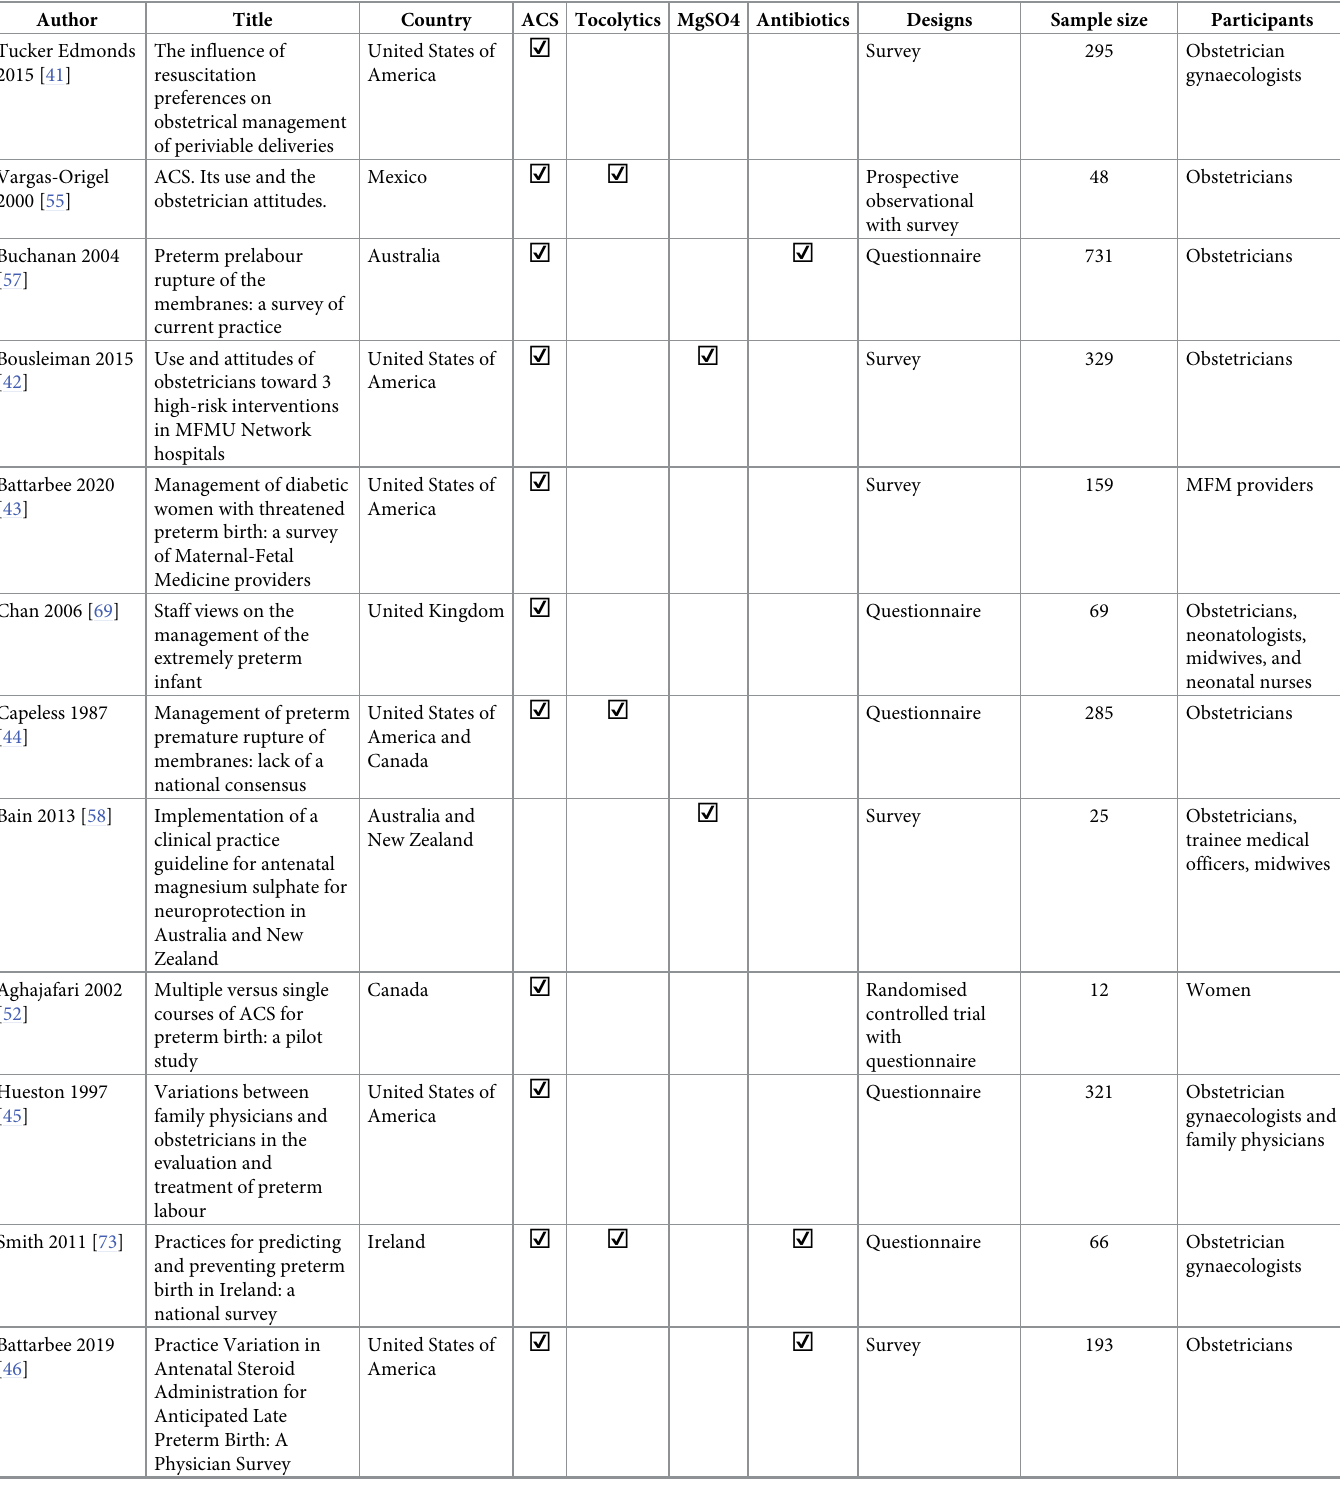
Table 2. Characteristics of included